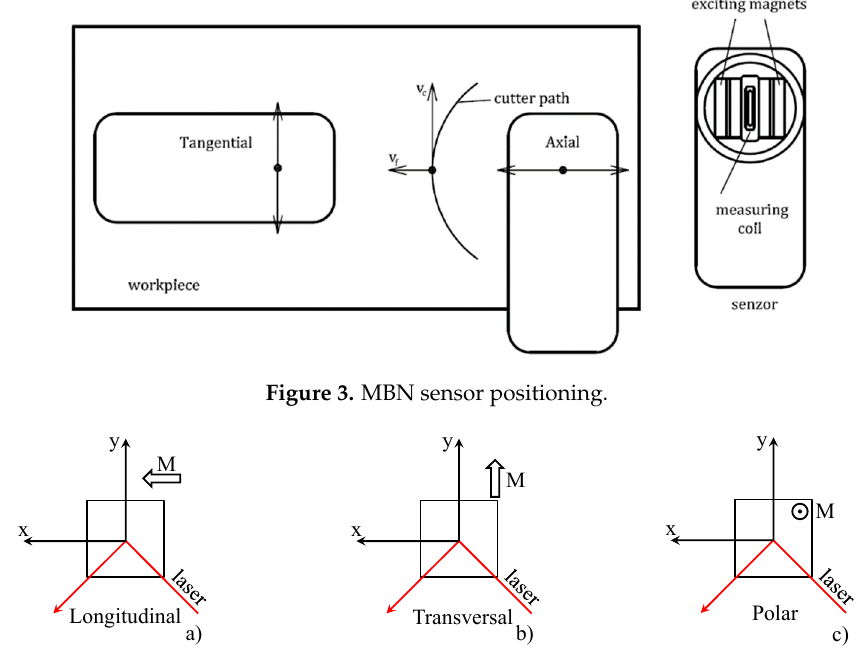
Figure 4. 3 basic configurations during measurement of Kerr rotation. ( a ) Longitudinal direction; ( b ) transversal direction; ( c ) polar direction.